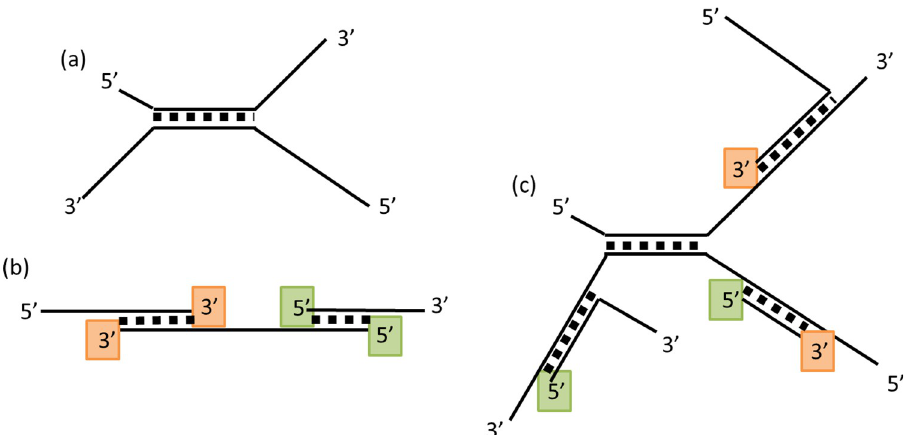
Fig 1. Examples of structures that form via annealing of strands. (a) If a helix forms in the middle of the strands, so that the ends of the strands are in single-stranded tails, then no growth is possible at these ends. (b) If the 3’ end of a strand is the last base in a helix (orange squares), this is a site for monomer addition. If the 5’ end of a strand is the last base in a helix (green squares), we assume that monomer addition cannot occur, but this is a potential site for ligation, if the 3’ end of another strand grows to be adjacent to this site. (c) Connection of multiple strands forms branching clusters with many tails and many potential points of sequence growth. We assume that formation of an additional helix is not possible between strands that are already in the same cluster. This prevents unrealistic loops and knots forming within a cluster.